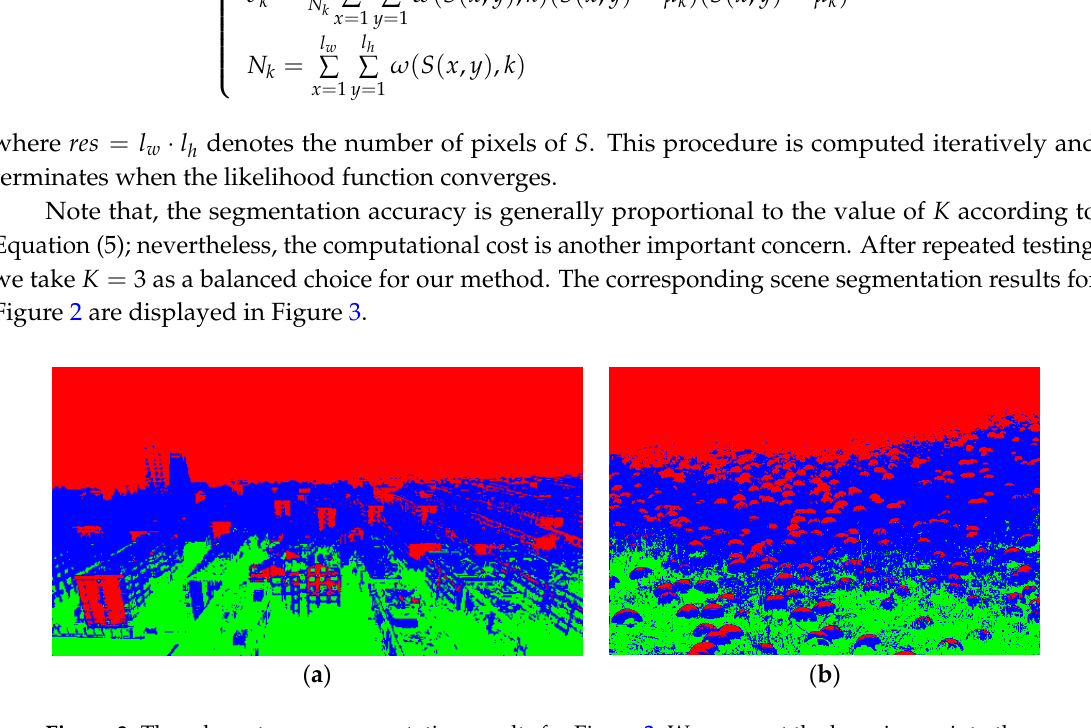
Figure 3. The relevant scene segmentation results for Figure 2. We segment the hazy image into three scenes and mark them using red, green and blue, respectively. ( a ): The scene segmentation result for Figure 2a (left). ( b ) The scene segmentation result for Figure 2a (right). (c)